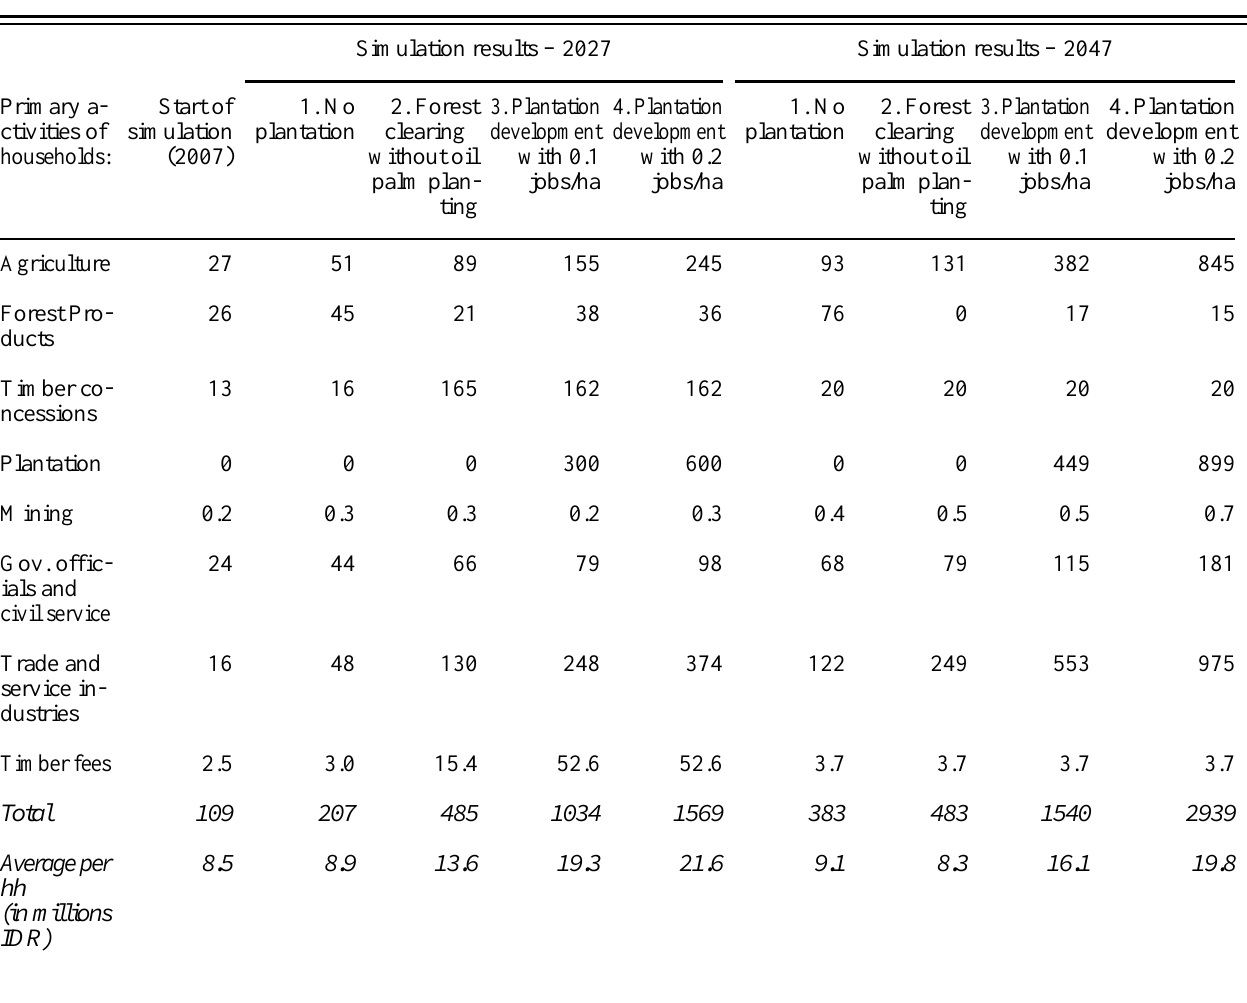
Table 3. Total income (in billions IDR) per sector for all households in Malinau, with the last row showing averages per